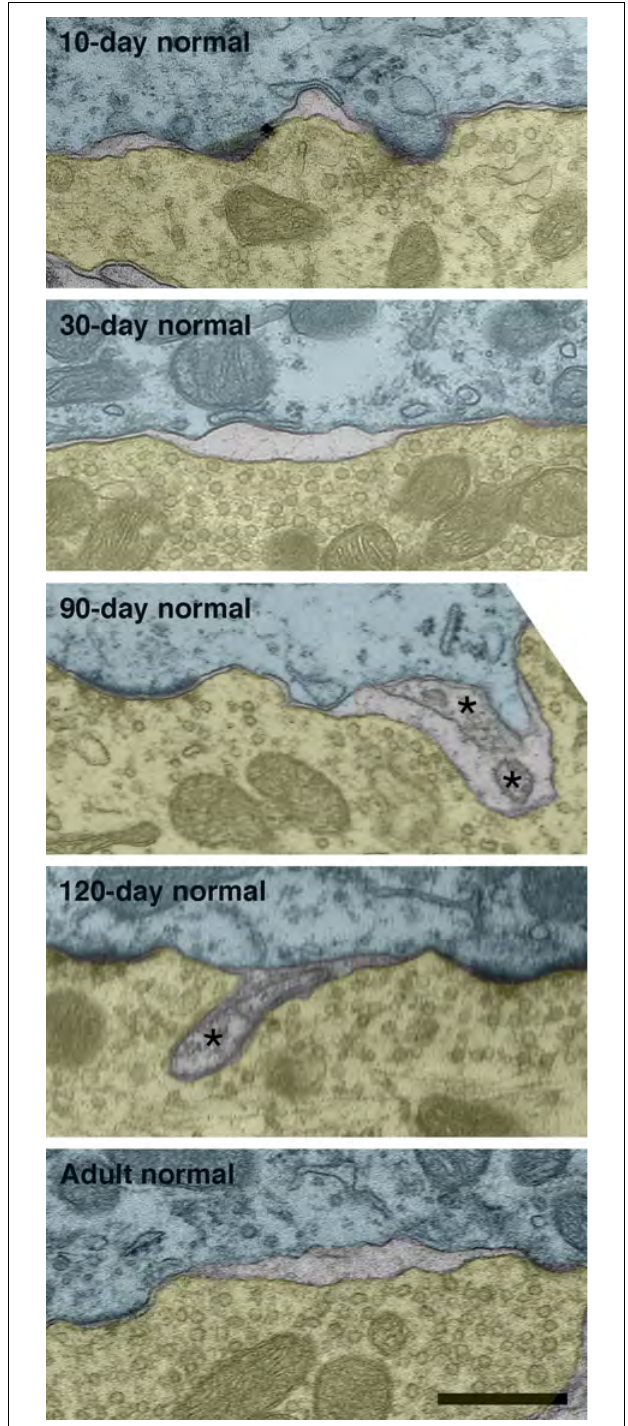
FIGURE 13 | Intermembraneous cisternae in 10-day, 30-day, 90-day, 120-day, and adult normal hearing cats. At around 10-days postnatal, endings of normal hearing kittens start developing spaces between the membranes of SBCs (green) and endbulbs (yellow). These spaces are not artifacts of fi xation as surrounding structures are well preserved. Note that cisternae are often found in proximity to PSDs. Occasionally structures (asterisks) can be found occupying the intermembraneous spaces. Scale bar equals 0.5